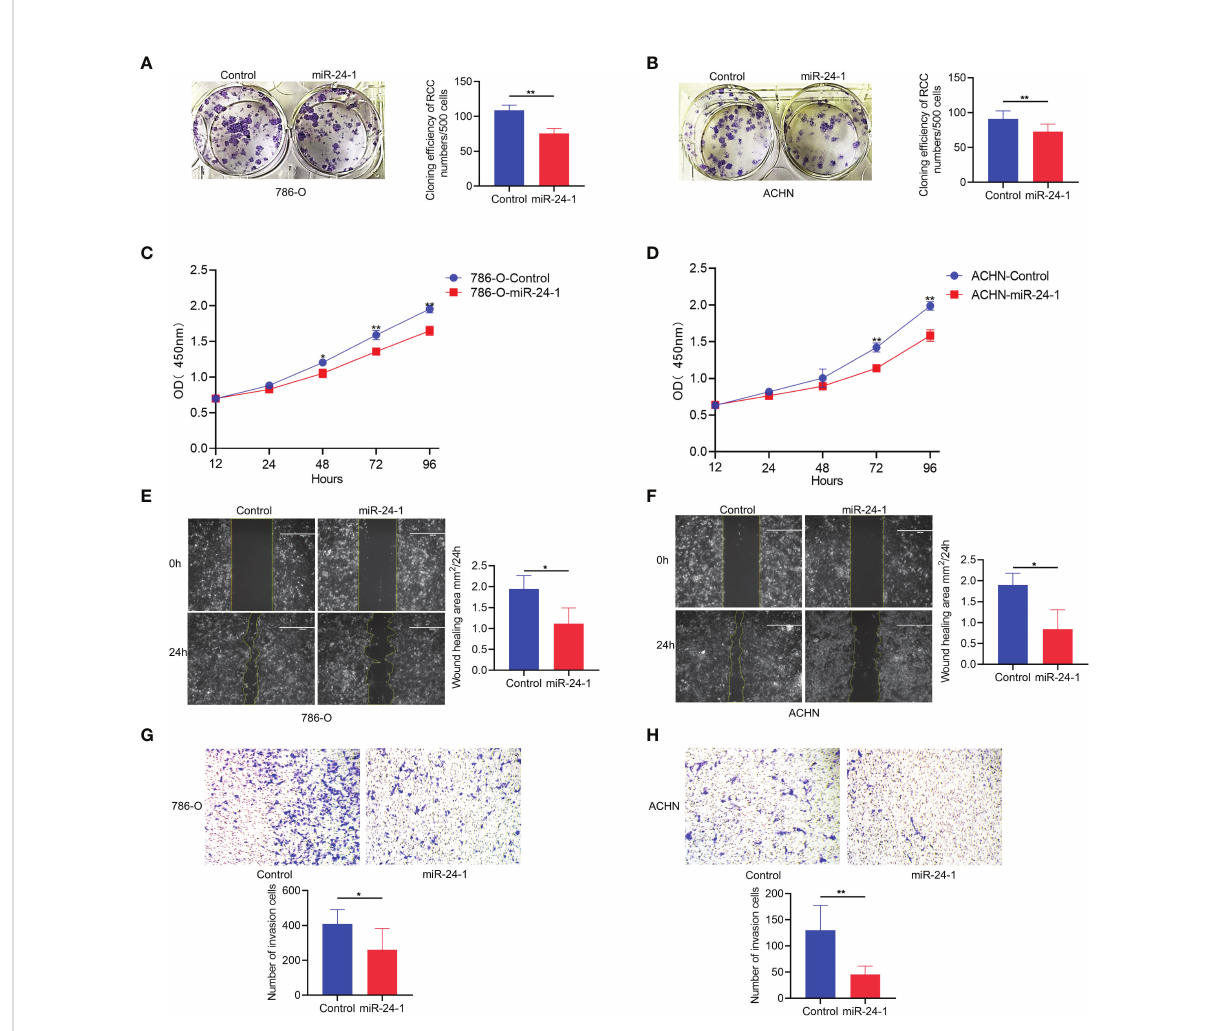
FIGURE 3 FBP1 can be activated by miR-24-1 and inhibit the proliferation and migration of RCC cells. (A, B) The colony formation ability of 786-O (A) and ACHN (B) cells was inhibited after overexpressing miR-24-1 in colony formation assay. (C, D) The proliferation ability of 786-O (C) and ACHN (D) cells was blocked after overexpressing miR-24-1 in CCK8 assay. (E, F) The migrating abilities of 786-O (E) and ACHN (F) cells were inhibited after overexpressing miR-24-1 in would healing assay. (G, H) The migrating and invasive abilities of 786-O (G) and ACHN (H) cells were repressed after overexpressing miR-24-1 in transwell assay. Results are shown as mean ± S.D. of triplicated experiments, **p < 0.01, *p<